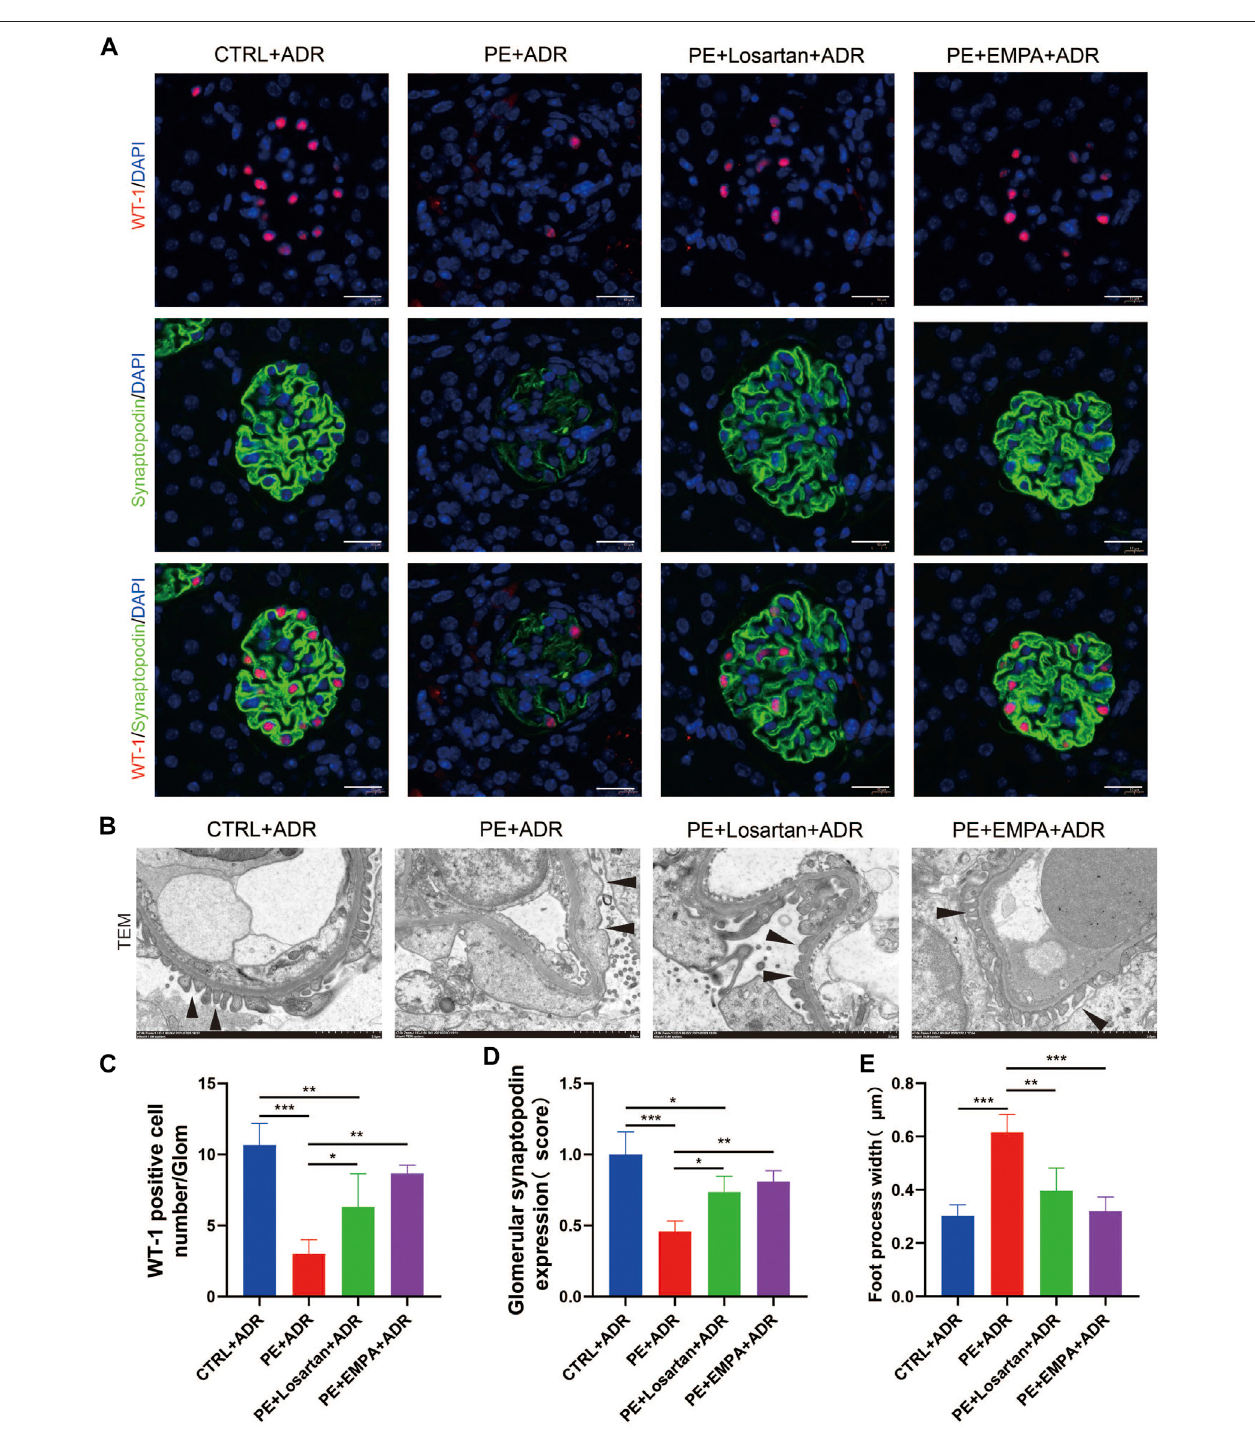
FIGURE 9 | EMPA treatment during pregnancy limited postpartum glomerular podocyte damage in response to ADR in AT1-AA-injected maternal mice. (A) RepresentativepicturesofWT1-positivepodocytes(red) and synaptopodin (green)inmouse glomeruliafter ADRinjection. Sections werecounterstained forDNA(blue). Scale bar: 20 μ m. (B) Representative transmission electron microscopy (TEM) micrographs of glomeruli from ADR-stimulated postpartum mouse kidneys reveal podocyteultrastructurechanges;podocytefootprocessesareindicatedbyarrowheads.Scalebar:2 μ m. (C) Quanti fi cationofWT-1-positivecells/glomerulus( n = 3) and (D) synaptopodin expression ( n = 3) in mouse glomeruli after ADR injection. (E) Quantitative podocyte foot process width ( n = 3). Data are expressed as the mean ± SEM and were analyzed by ANOVA with LSD post hoc test. * p < 0.05, ** p < 0.01, *** p < 0.001.